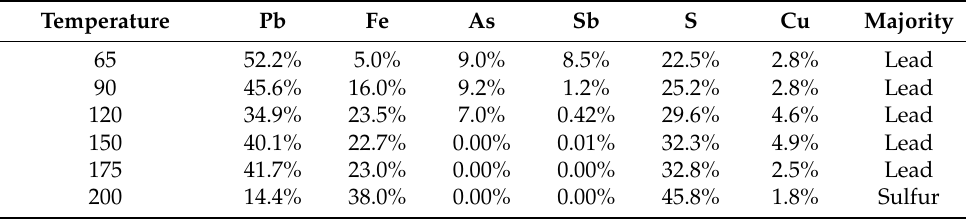
Table 17. Mass of elements in percentage for modified kinetics